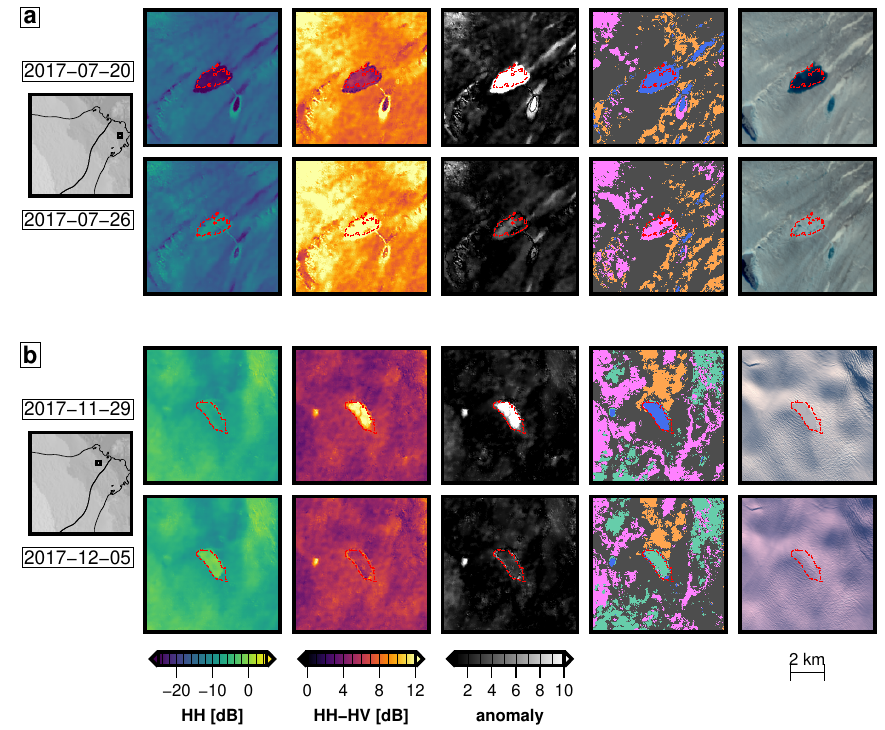
Figure 7. Two examples for supraglacial lake drainages in PolSAR data, classification results (colors as in Figure 3) and corresponding optical images. The red line marks the automatically determined outline polygon of this lake. ( a ) shows a typical summer time drainage with a characteristic increase in HH, ( b ) shows a typical winter time drainage with a characteristic decrease in HH–HV. The optical imagery in ( b ) originates from 10/2017 and 03/2018. More examples can be found in the Supplementary Material.